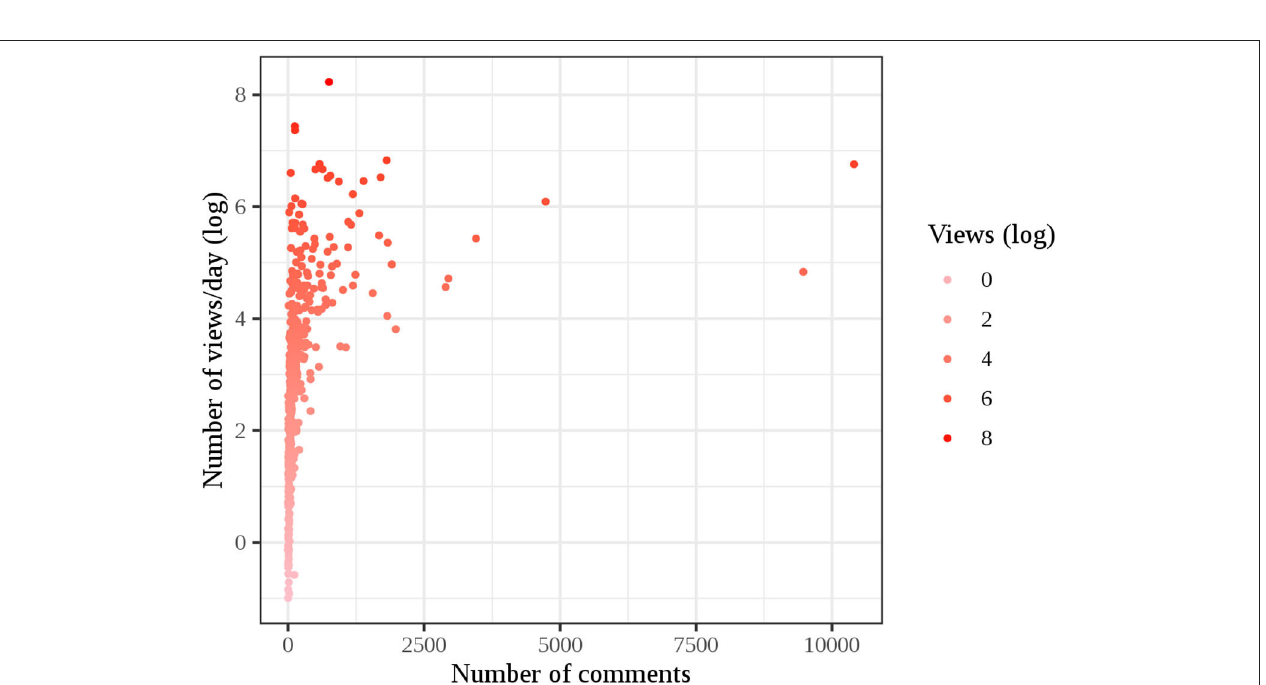
FIGURE 5 | Number of views (log) x number of likes.